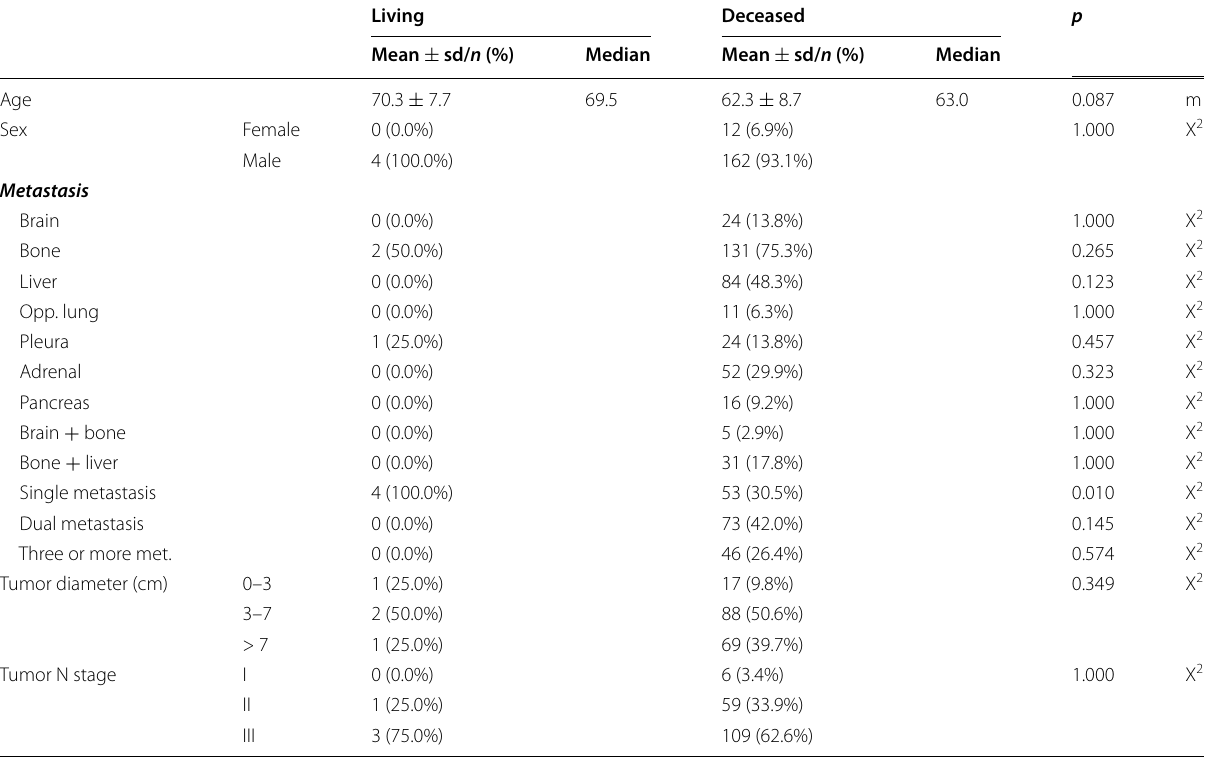
m Mann-Whitney U test/ X2 chi-square